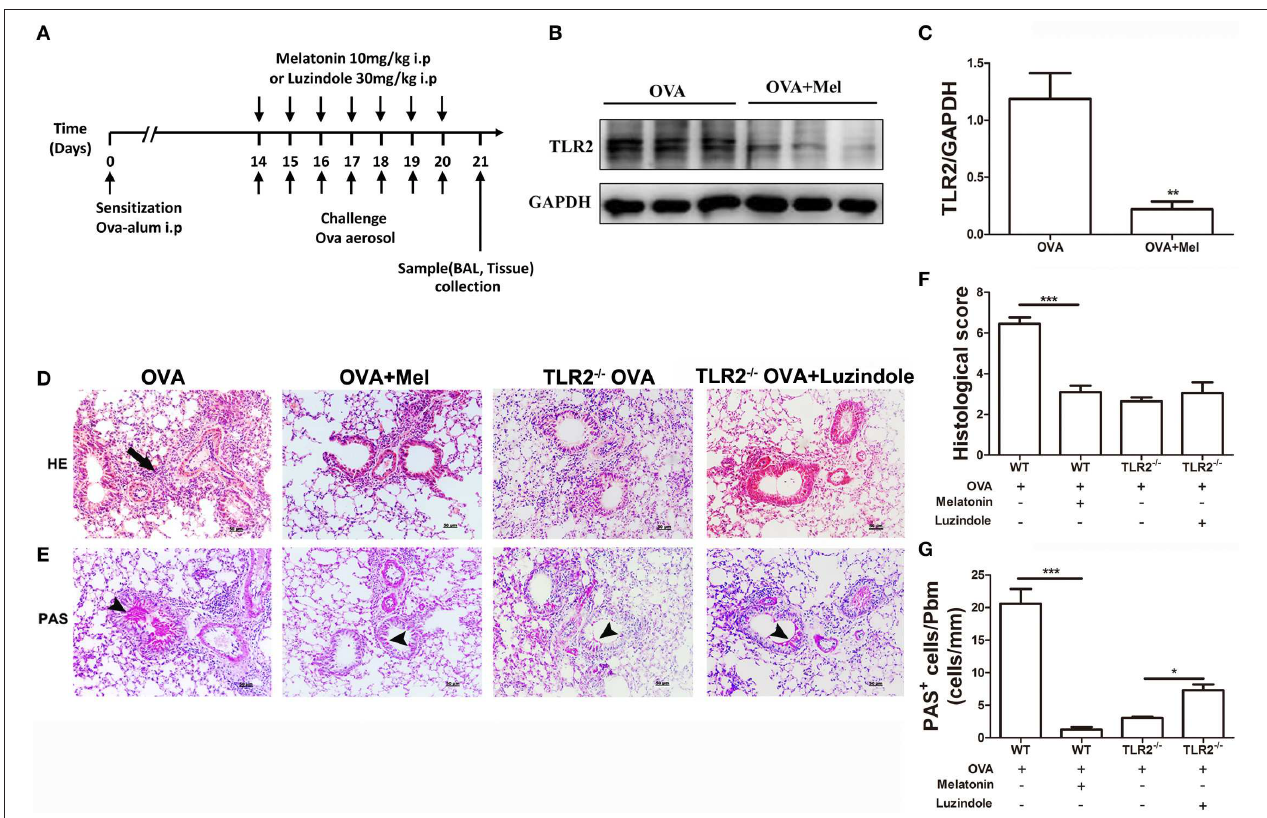
FIGURE 4 | The effect of melatonin or luzindole on OVA-induced airway inflammation. (A) Protocol of administration of melatonin or luzindole during establishing allergic airway diseases model. (B,C) Protein expression of TLR2 in lung tissues of OVA-challenged WT mice treated with melatonin or not. (D) Lung histopathology based on H&E staining to evaluate inflammatory cell infiltration, arrows indicates infiltrated leukocytes. (E) Mucus secretion was analyzed based on PAS staining, arrow heads indicates goblet cells. (F) Histological scoring of lung inflammation. (G) Quantification of mucus secretion. * p < 0.05, ** p < 0.01, *** p <